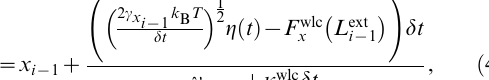
Figure 2. Illustration of the components considered for the time-stepping Langevin scheme used in this study. For each time step the microsphere moves to a new position due to (i) thermal noise, (ii) an elastic response from the DNA molecule that acts like an entropic and F wlc , respectively, (iii) a restoring force spring in both x and z , F wlc x z produced from the magnetic field F mag , (iv) the weight of the microsphere, F mg , and (v) viscous drag in x and z , F and F , respectively. The red cross indicates the bottom of the microsphere and DNA attachment point indicating no rotation, due to the alignment of the bead in the magnetic field. Note that the microsphere here has finite extent but is treated as a point in the simulations and the y-axis has variables equivalent to those in x.